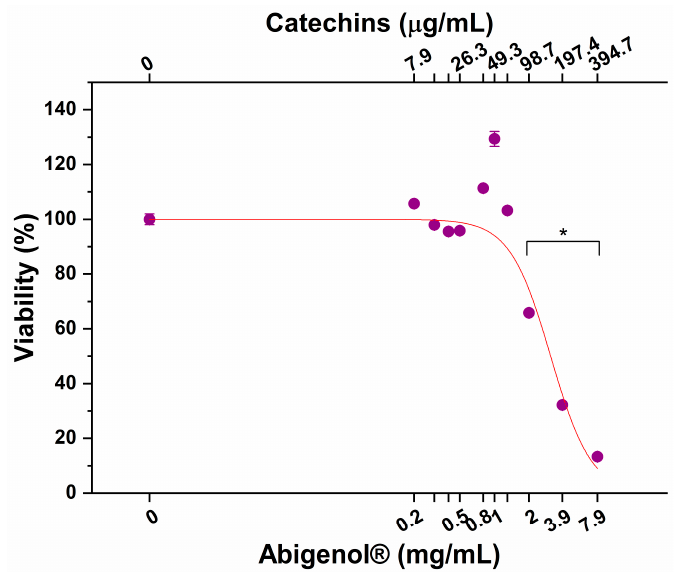
Figure 2. Impact of increasing concentrations of digested Abigenol ® /AlbiPhenol ® on the vitality of the intestinal epithelium. * p < 0.05. (n =